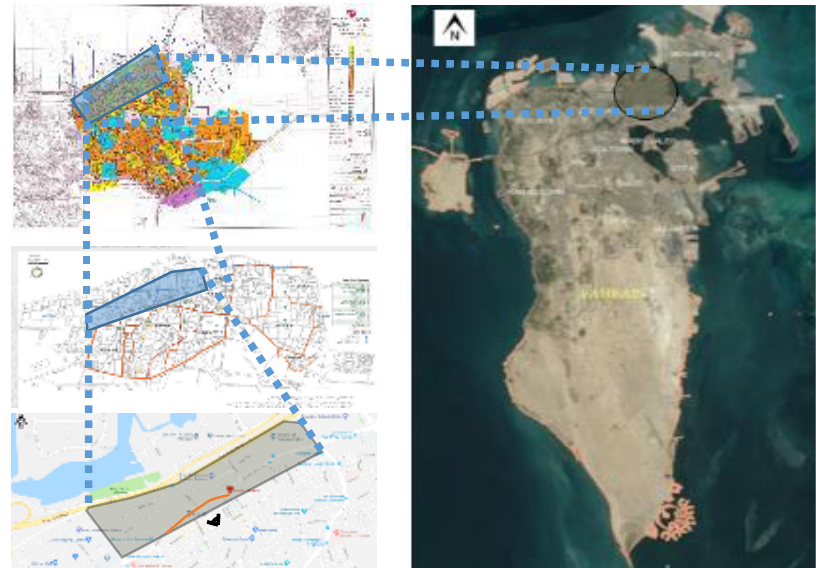
Figure 6. Location of the pilot study of: “Bab Al Bahrain”, Governorate Road, Old Manama, Kingdom of Bahrain